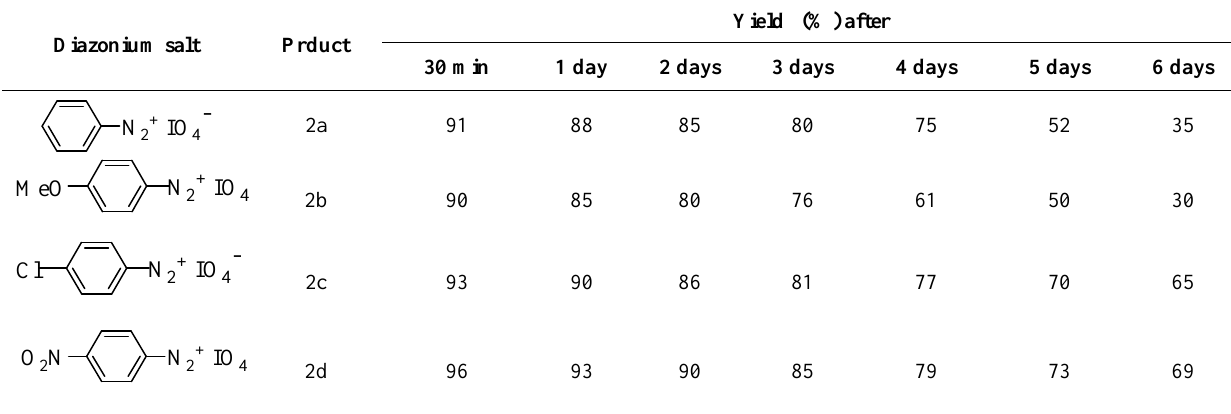
a The yields refer to the isolated pure products after adding 2-naphthol into their corresponding diazonium salts within the specified